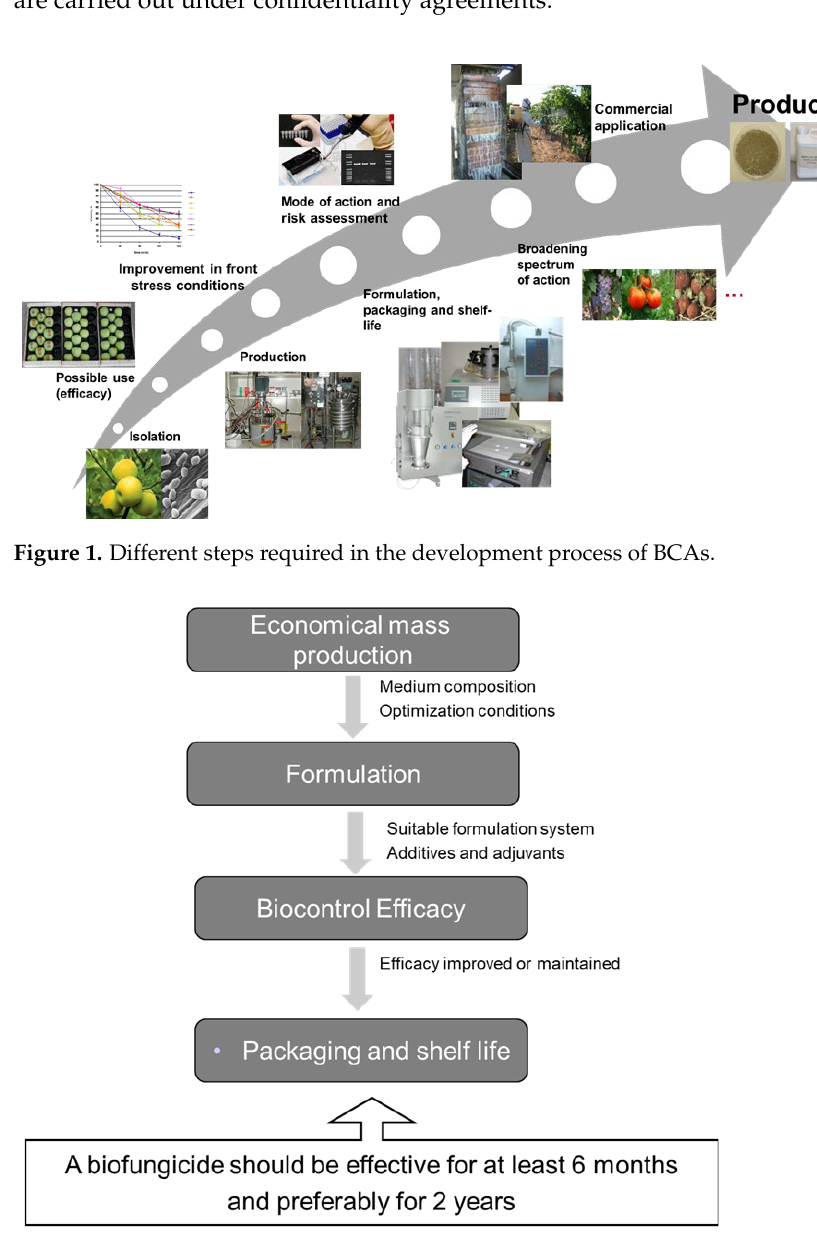
Figure 2. Generic layout to obtain an antagonist-based product.